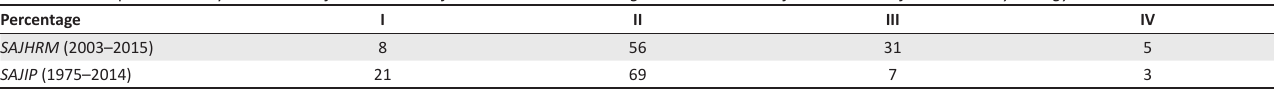
TABLE 6: A comparative analysis of South African Journal of Human Resource Management and South African Journal of Industrial Psychology